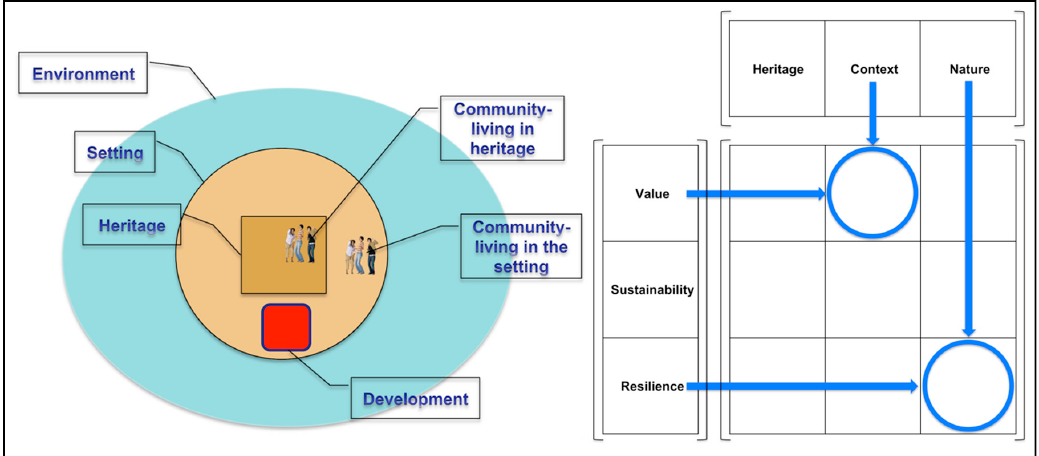
Figure 4. The intervention matrix perspective proposed by the authors in previous research.